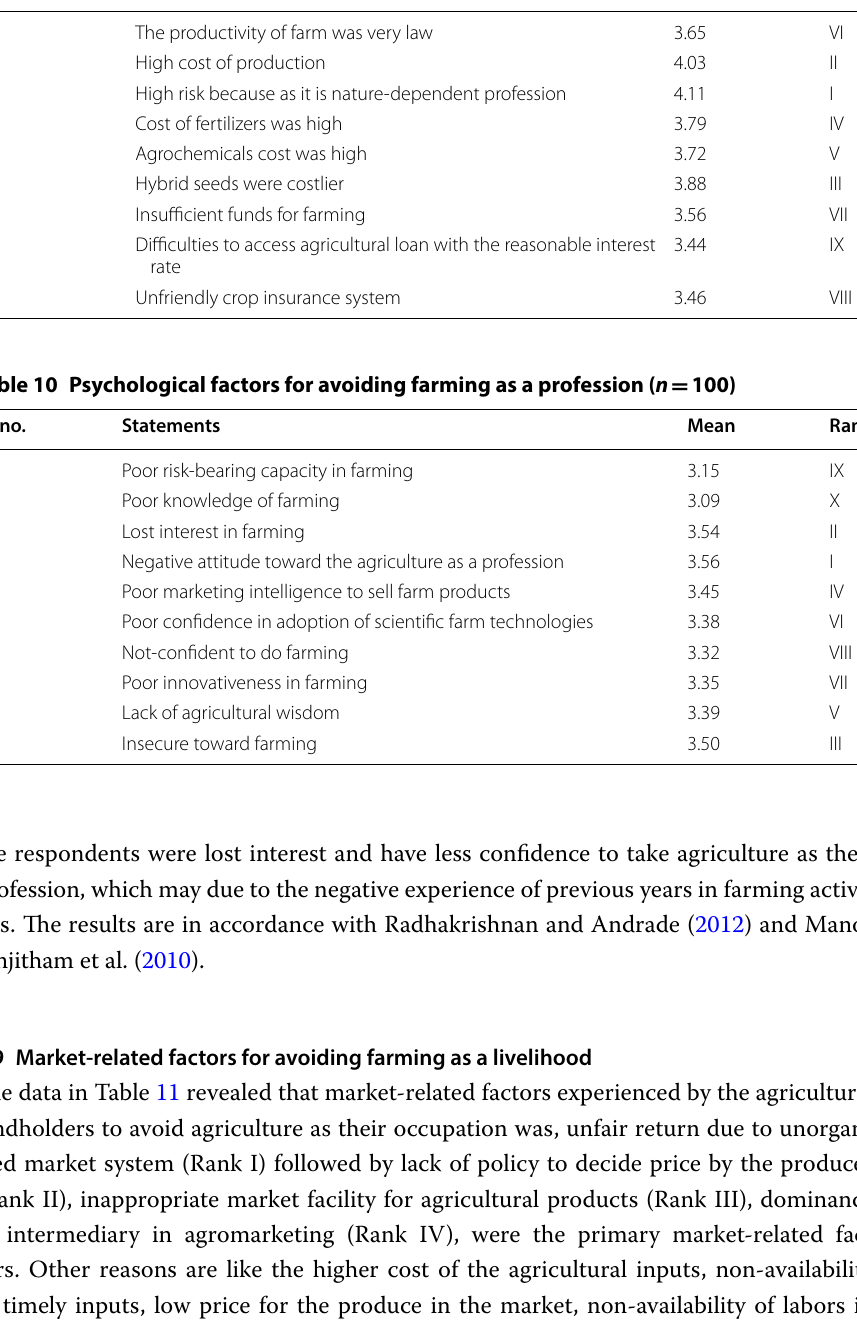
Table 9 Economic factors for avoiding farming as a profession ( n Sr. no.